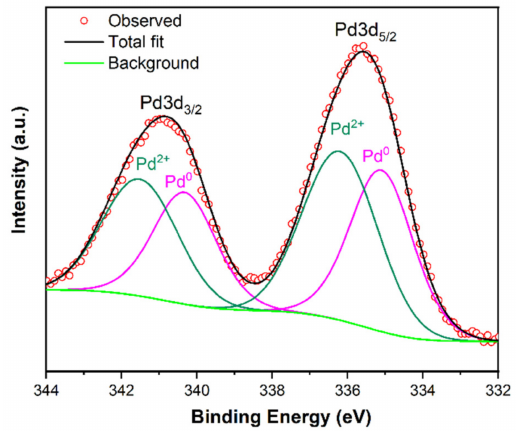
Figure 3. The Pd 3d X-ray photoelectron spectra of the Du1800-Pd